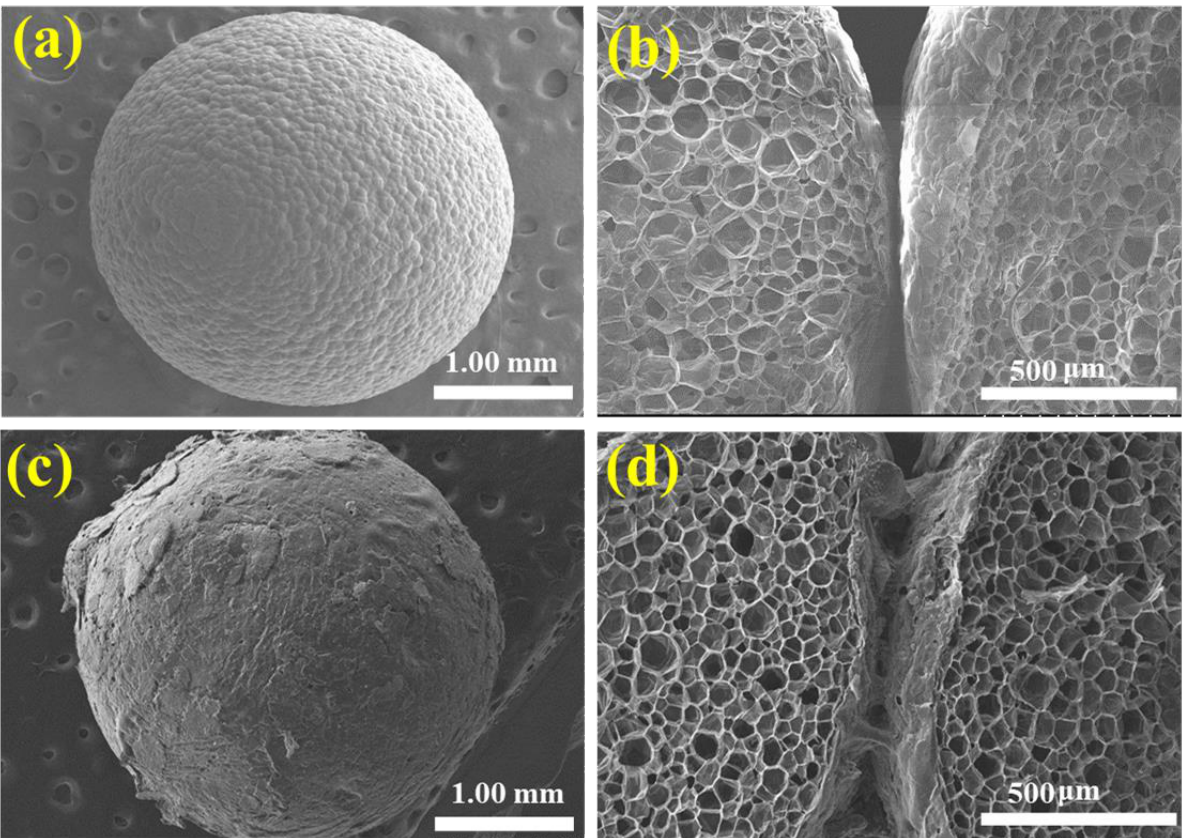
Figure 2. The SEM and cross-sectional SEM images of the neat EPS ( a , b ), and the EPS/HFR12 ( c , d